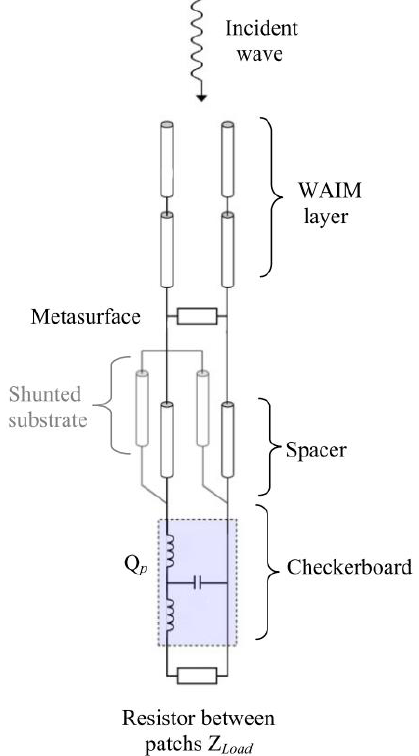
Figure 2. Transmission line (TL) model of the absorber corresponding to Figure 1a.